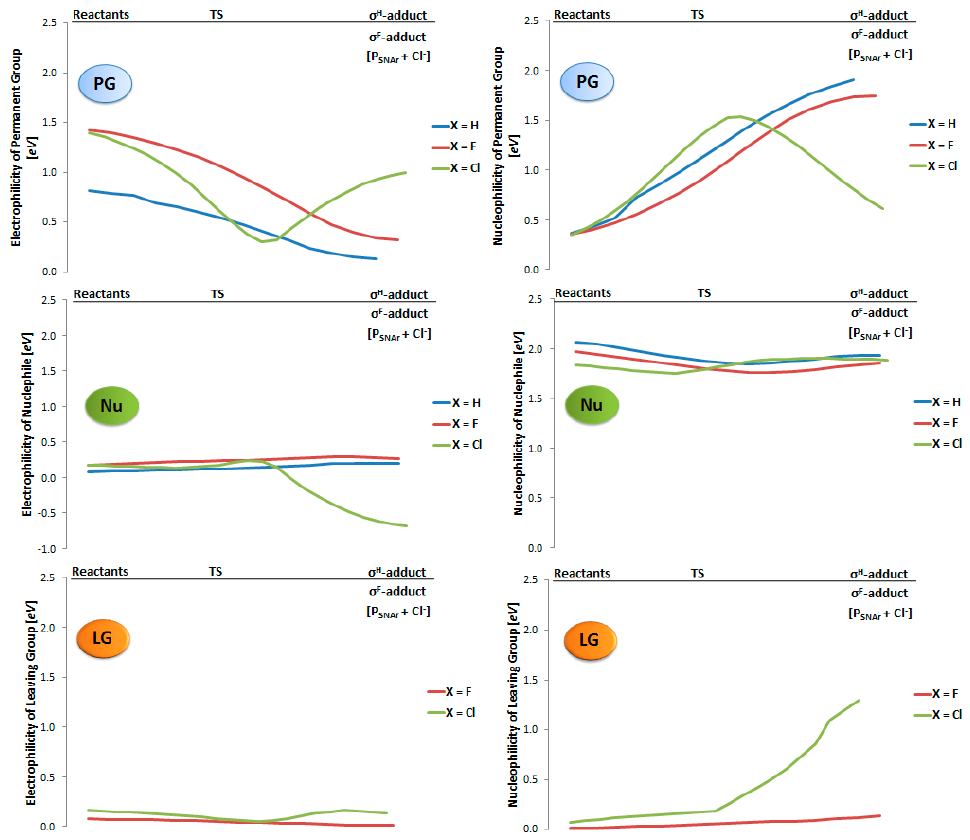
Figure 7. Changes of electrophilicity for permanent group (PG) ( upper left ), leaving group (LG) ( middle left ) nucleophile (Nu) ( lower left ) and nucleophilicity for permanent group (PG) ( upper right ), leaving group (LG) ( middle right ) and nucleophile (Nu) ( lower right ) during nucleophilic substitution in the para position.